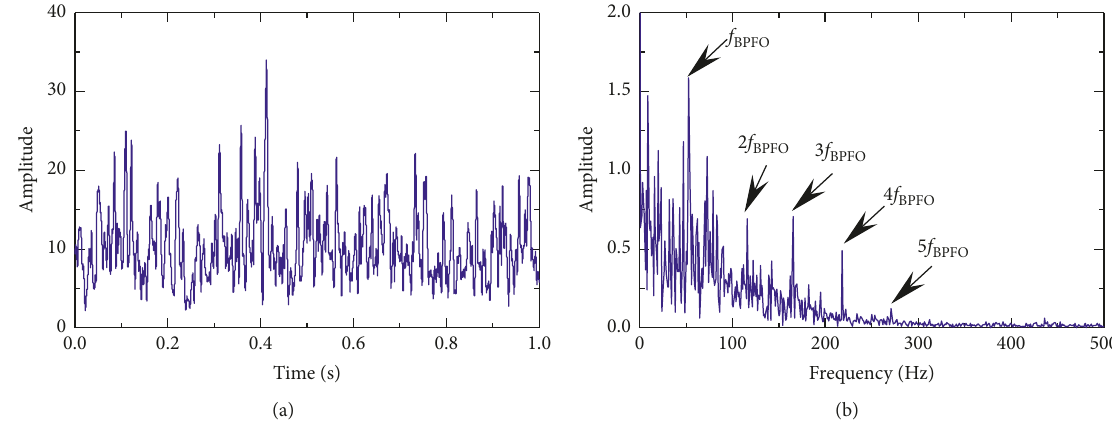
Figure 20: Case 2: waveform and spectrum of MECGMF filtering result: (a) time-domain waveform; (b) amplitude spectrum.